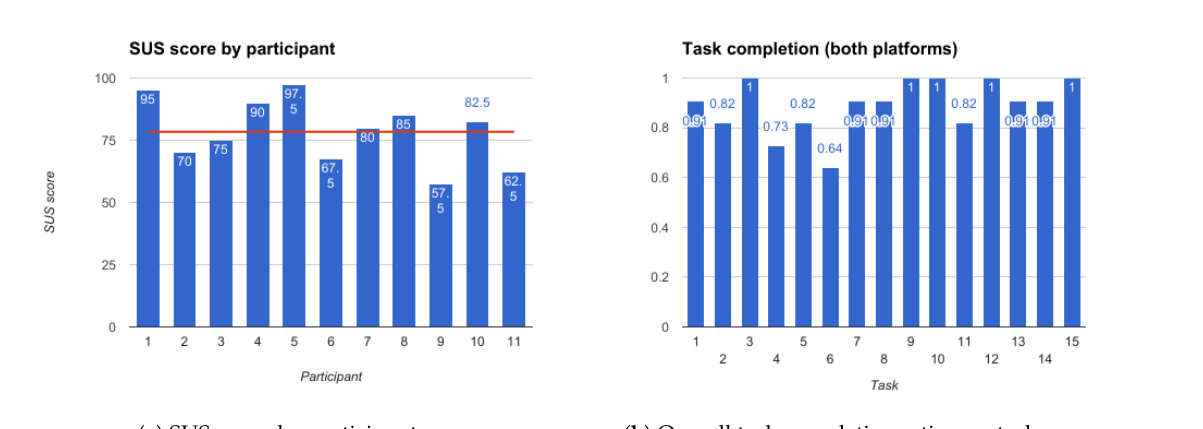
Figure 3. Results obtained for the evaluation of the second prototype of Geriatric Helper: ( a ) the System Usability Scale Scores (SUS); and ( b ) task completion